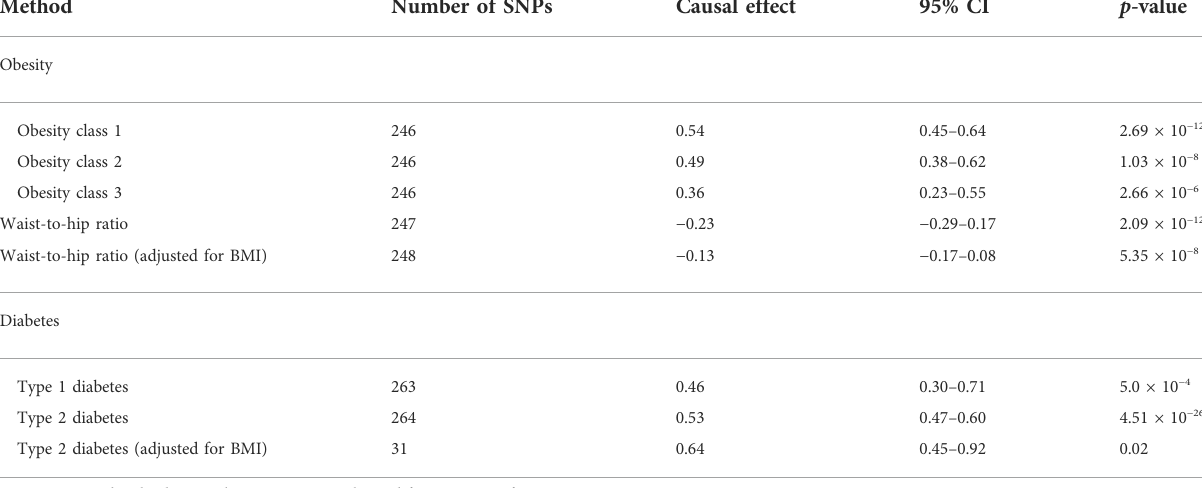
TABLE 2 Causal effect from educational attainment to endometrial cancer risk